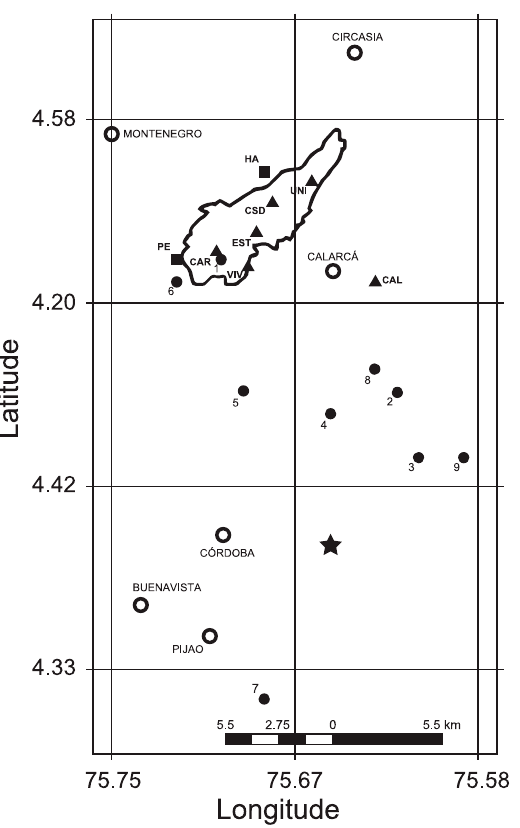
Figure 3. Location of the epicenter of the main shock of the 1999 earthquake (star) and of the nine analyzed aftershocks (solid circles, the numbers refer to Table 1). The contour with thick solid line indicates the city of Armenia. Triangles indicate the location of the accelerograph stations that recorded the aftershocks. Two squares indicate the two locations (HA and PE) where linear seismograph arrays were used to record microtremors, analyzed using the spatial autocorrelation (SPAC) method. Open circles indicate the location of towns around Armenia. Table 1. Epicentral coordinates of the nine aftershocks analyzed. The last column indicates the stations that recorded each event.